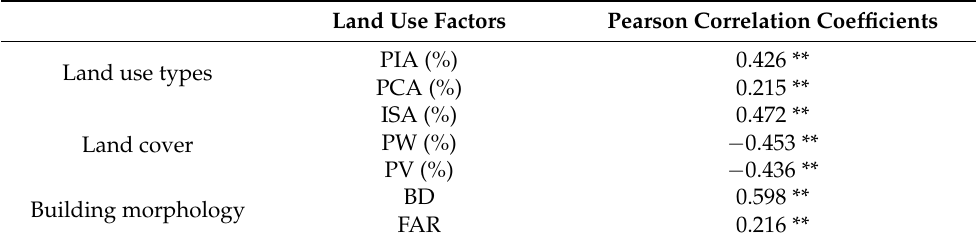
Table 4. Pearson correlation coefficients of the land use factors and LST.